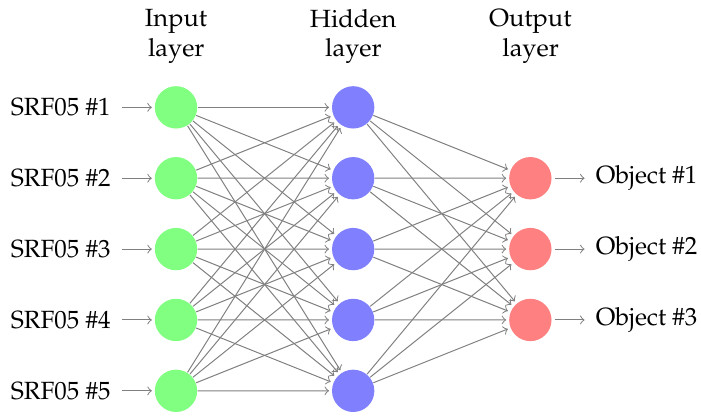
Figure 4. Structure of the neural network used for the experimental application.